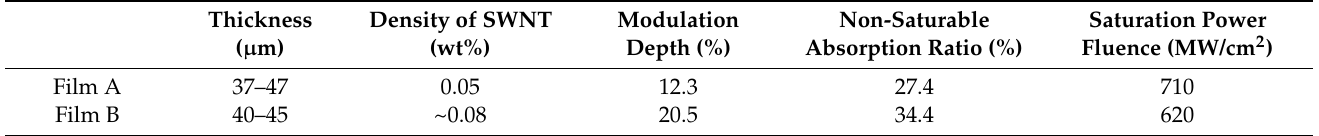
Figure 1. Configuration of Tm-Ho co-doped ultrashort pulse fiber laser using SWNT and in-line spectral filter. Table 1. Characteristics of film A and film B